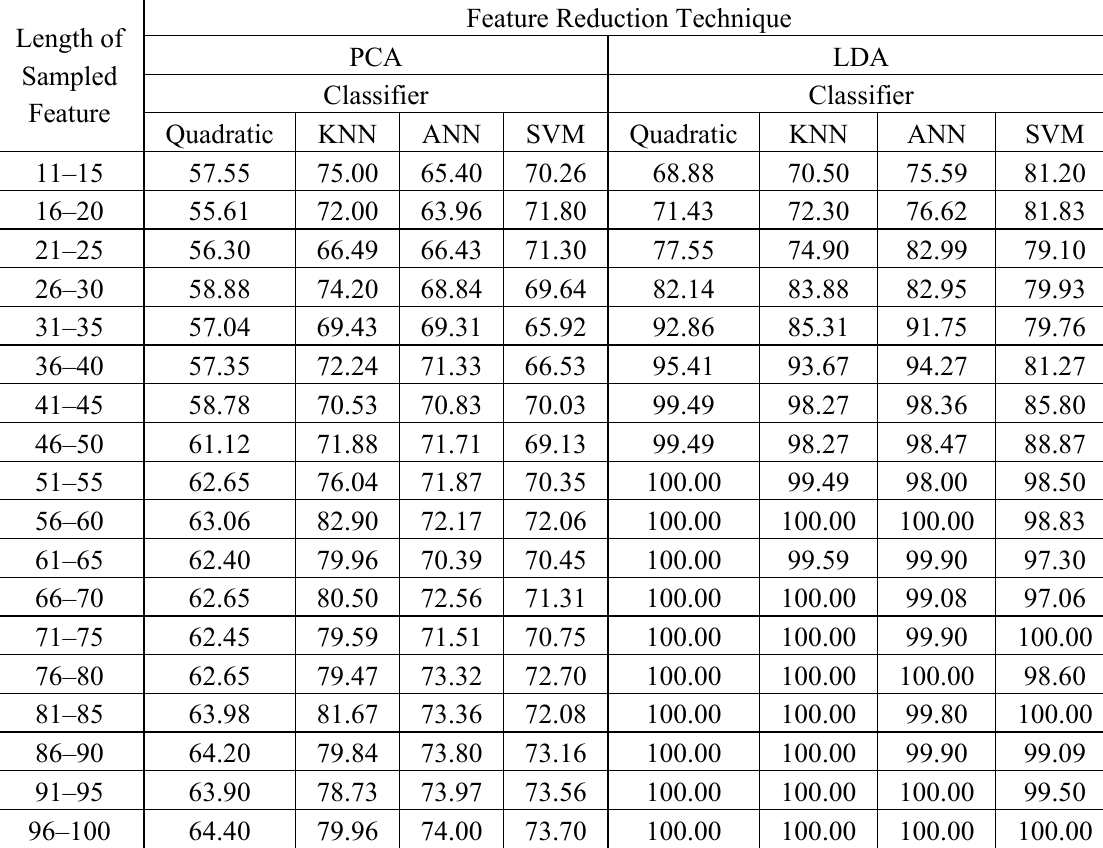
Table 2. Averages of evaluated classification rates for extracted features from baseline manipulated